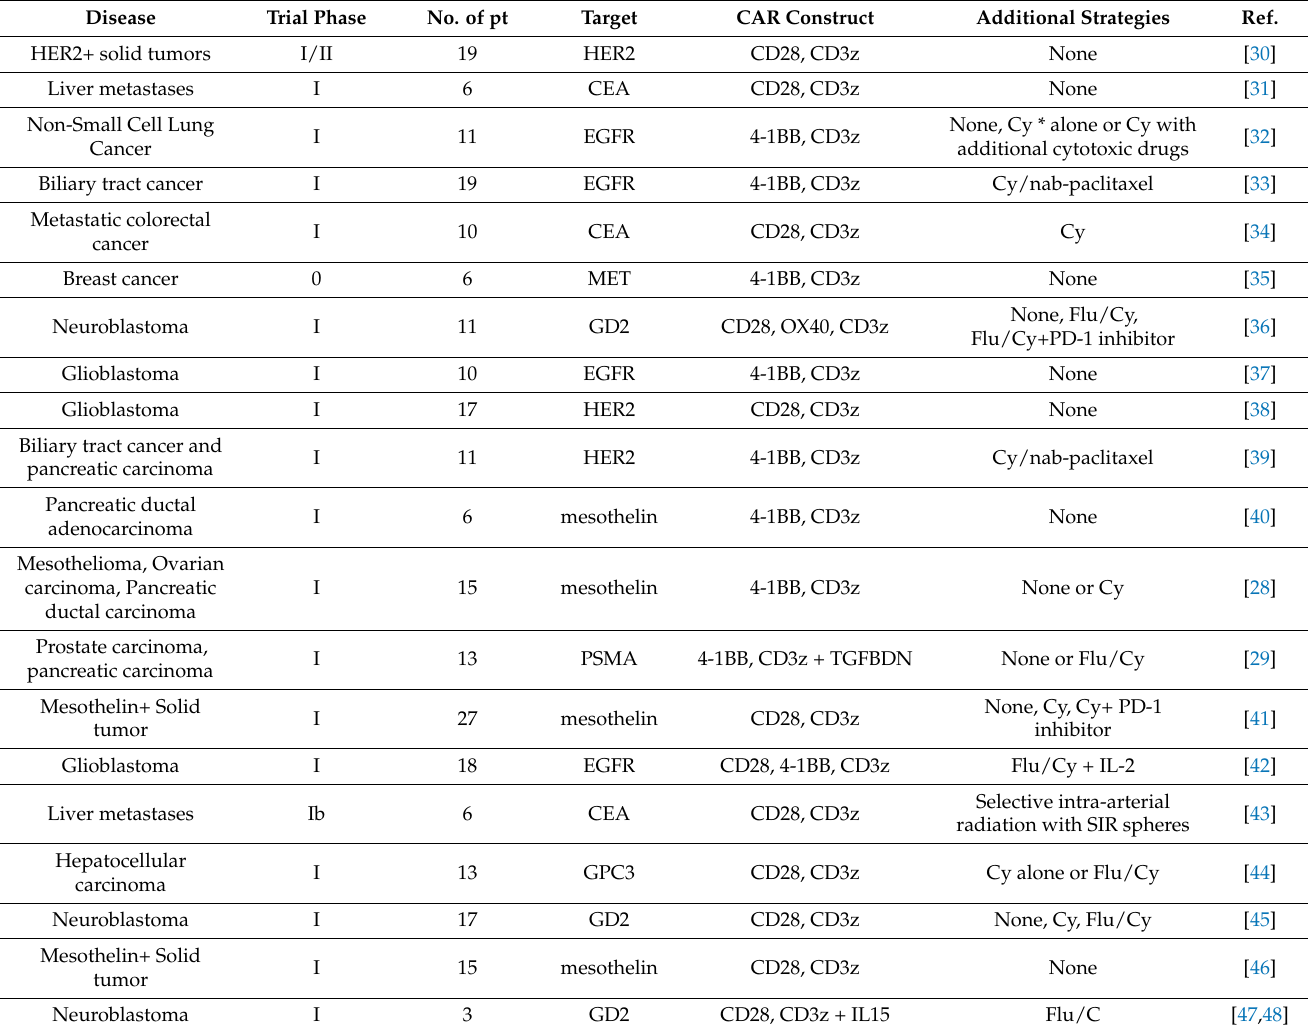
Table 1. Selected clinical trials utilizing second- and third-generation CAR T cells in solid